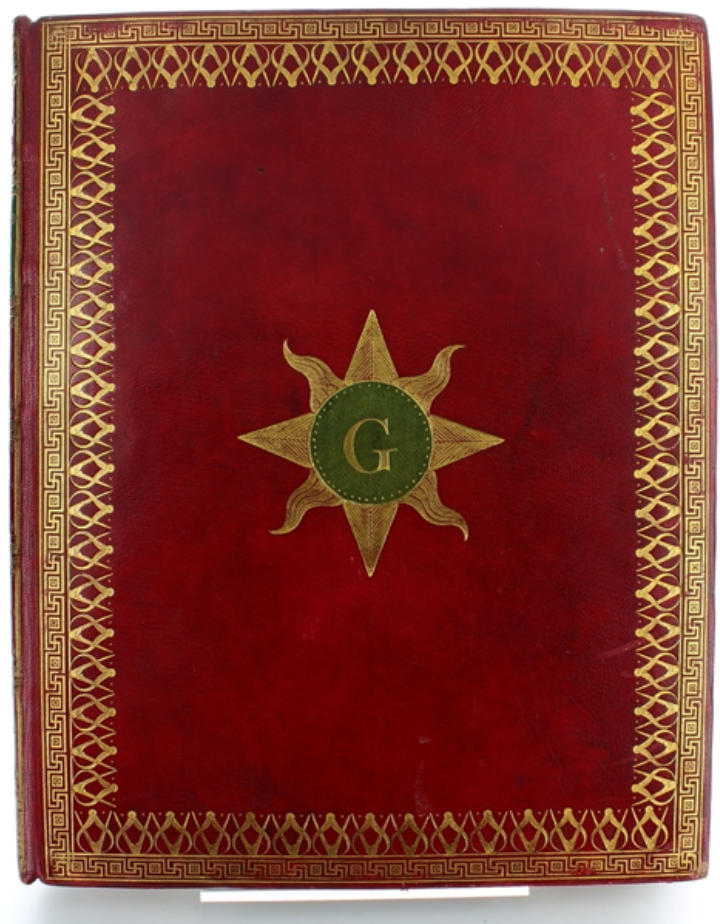
Fig. 18. Binding by Henry Walther for the Bedford Lodge. Note the superior leather, calf in this case, regular finishing and lack of scuffing. Copyright and reproduced by permission of the Museum of Freemasonry,